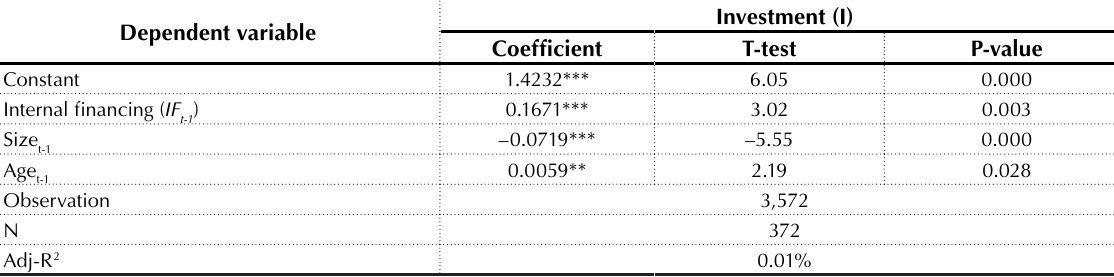
Table 2. The effect of internal financing on the